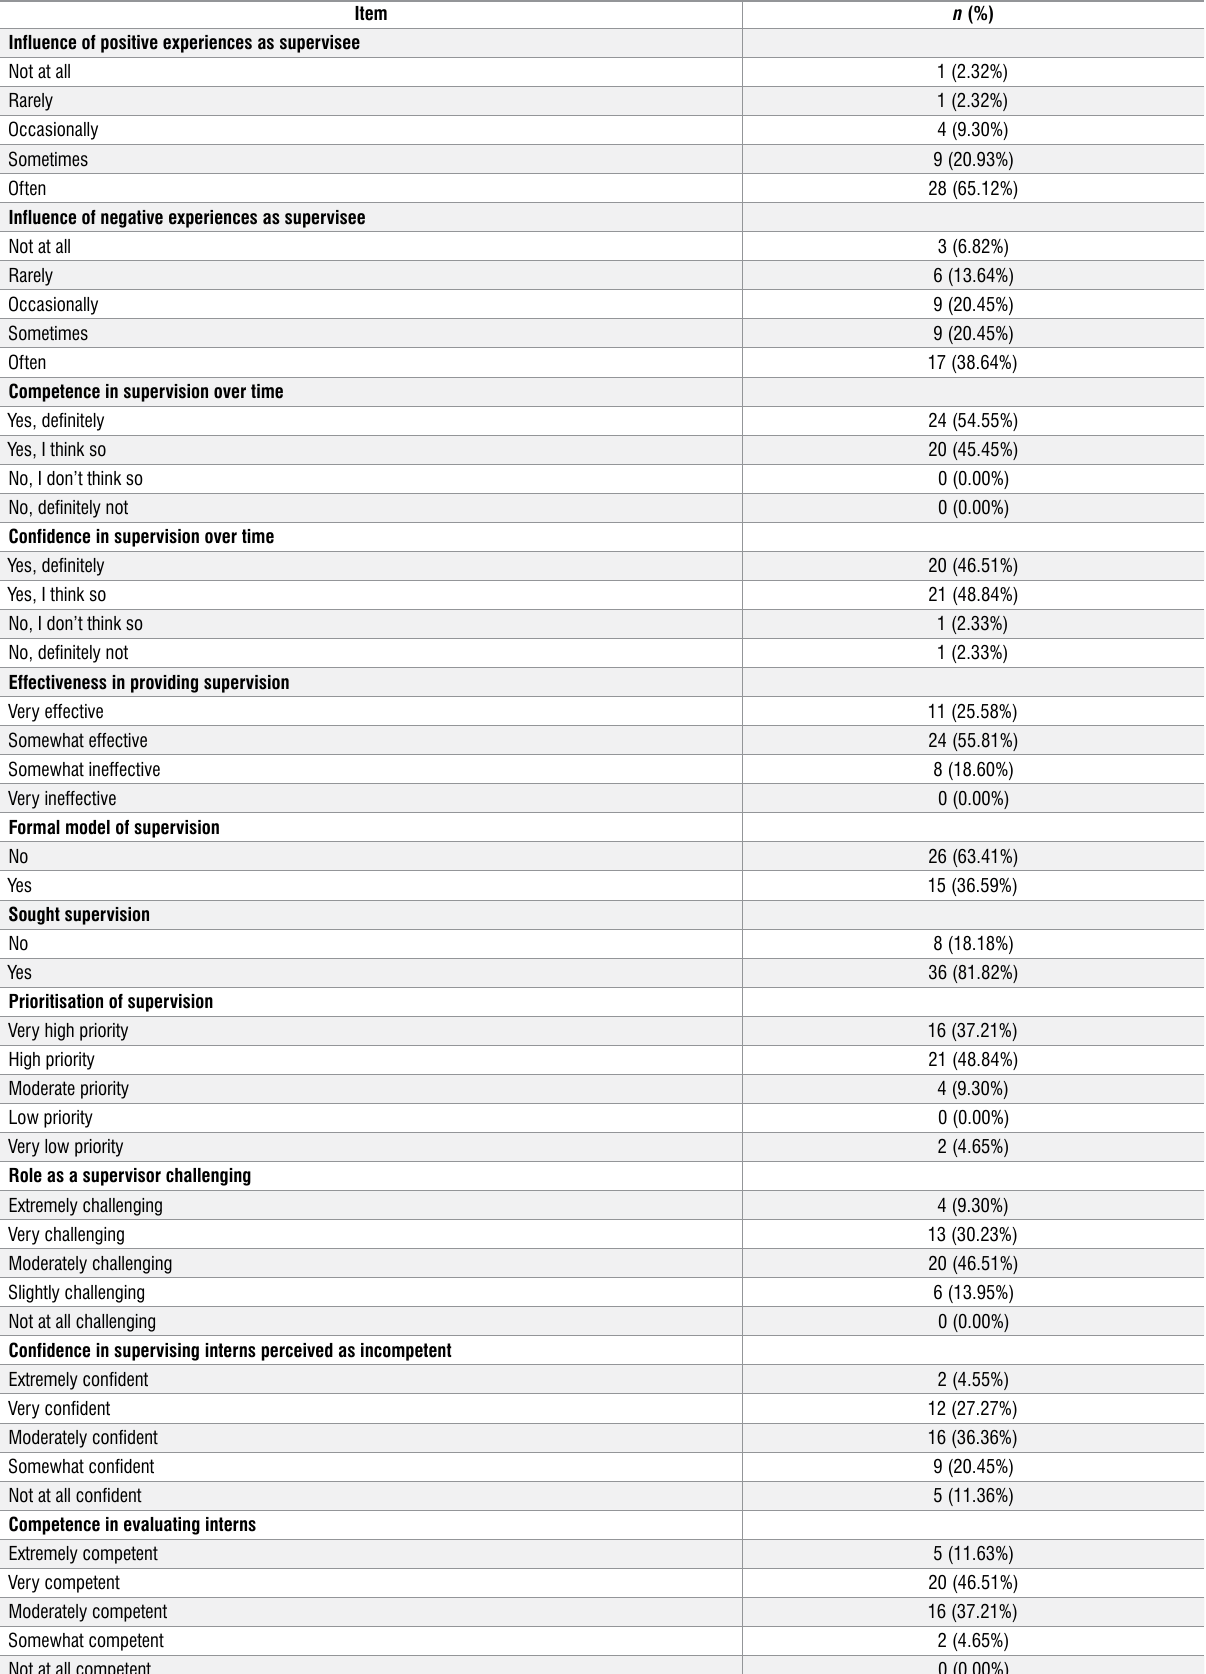
Table 3: Frequency statistics for perceptions of supervision experience, training, and abilities items Item n